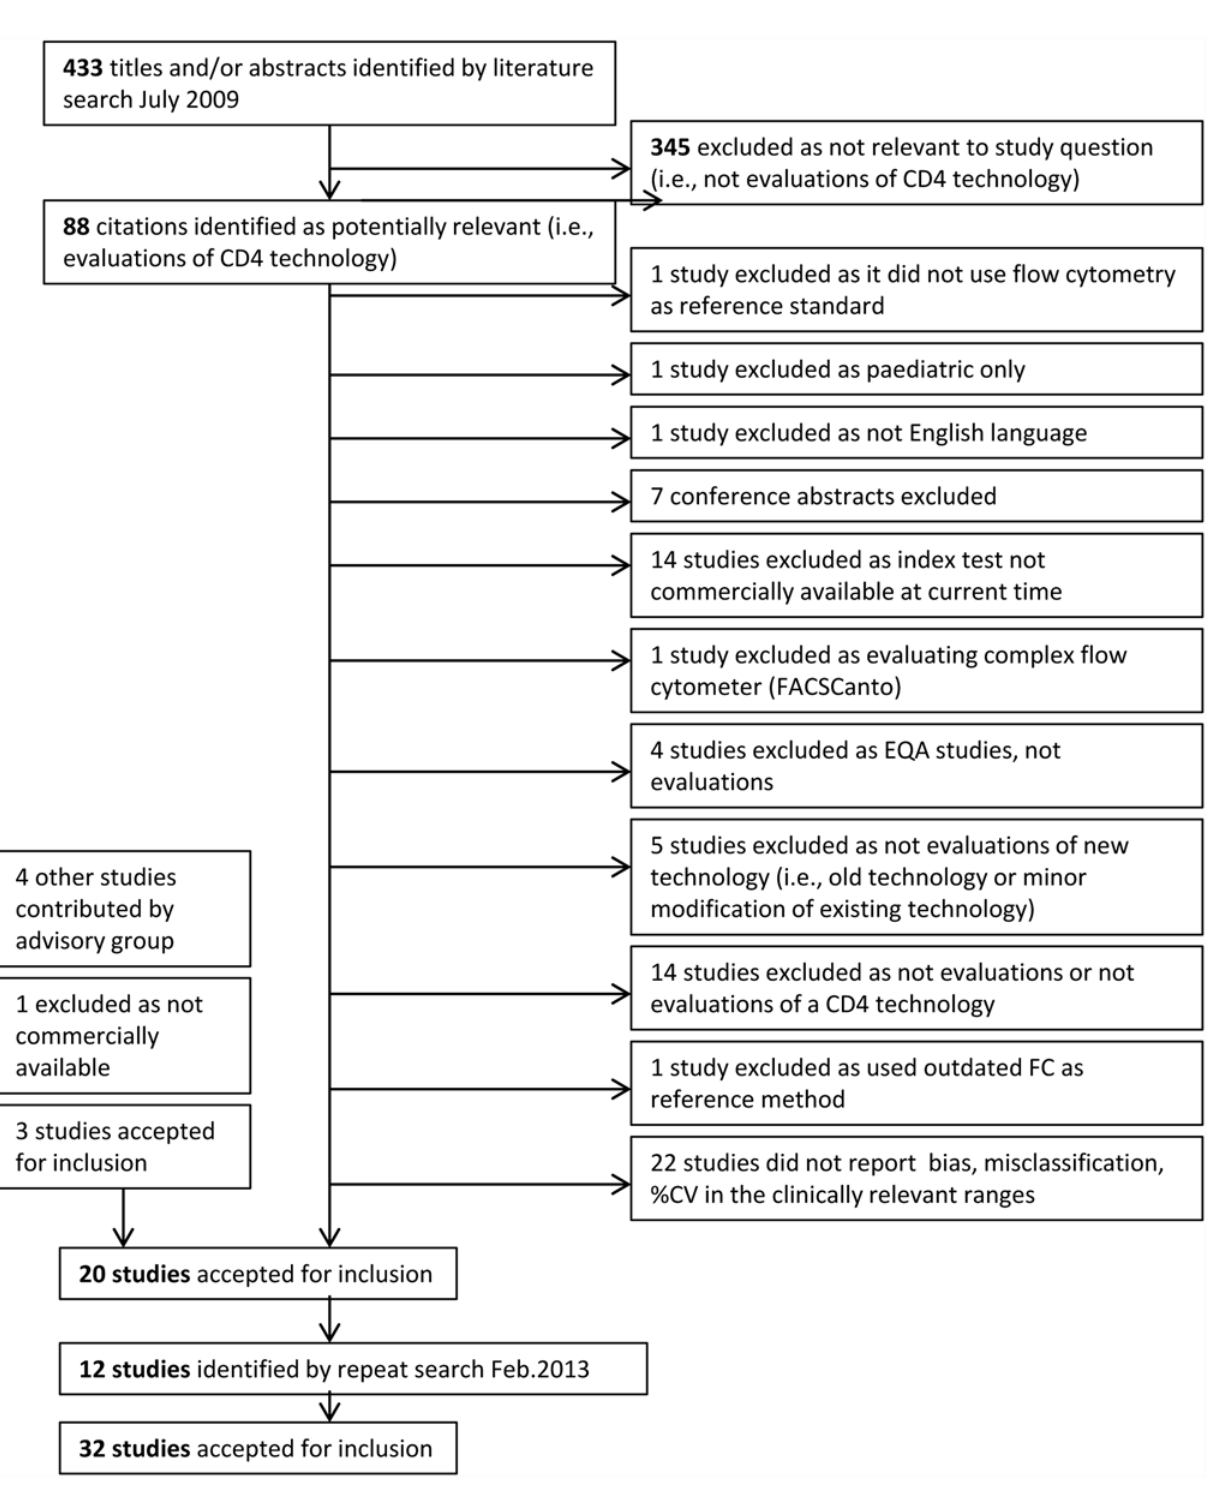
PLOS ONE | DOI:10.1371/journal.pone.0115019 March 19,